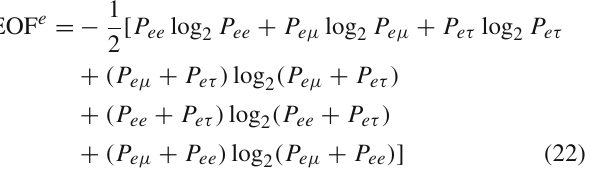
in Eq. (23); d Comparison of three entanglement measures (violet line: Negativity; pink line: Entanglement of Formation; wine line: Concur- rence) for initial electron flavor state. And the experiment data are from Daya Bay collaboration [3] in three underground experimental halls (EH1: blue, circle; EH2: green, square; EH3: black,